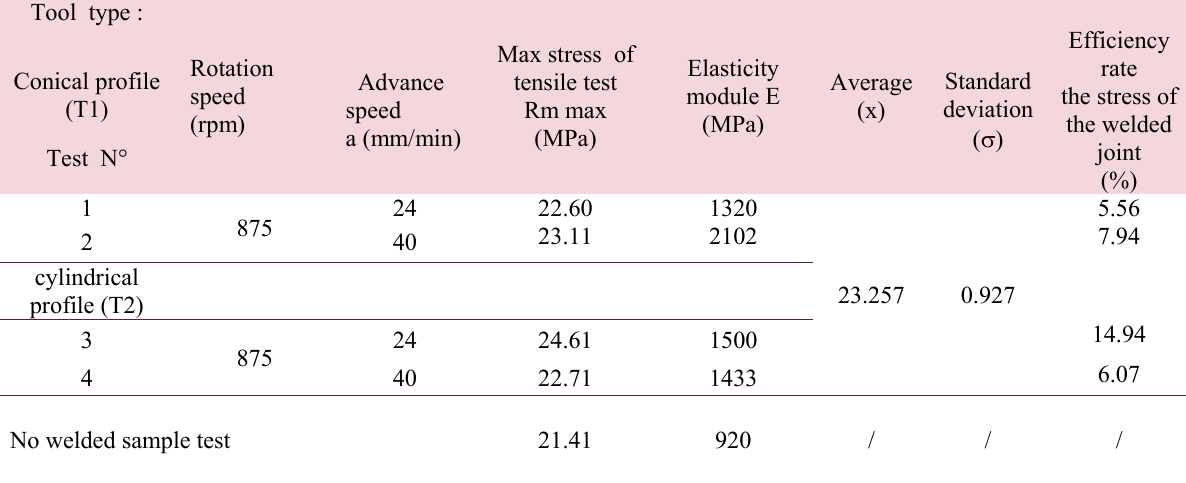
Table 4: Tensile strength values and their effectiveness on the welded